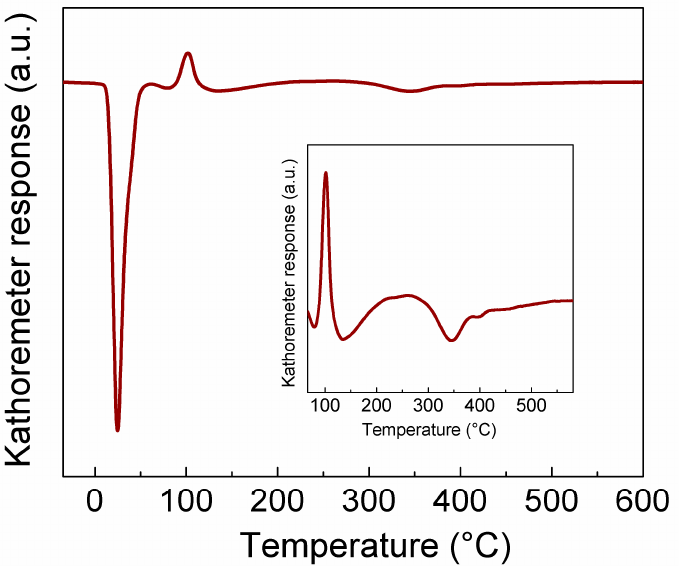
Figure 4. Temperature programmed reduction of 1 wt.% Pd/ γ -Al 2 O 3 after calcination in air at 500 ◦ C. Based on TPR results, the low-temperature reduction conditions were estimated. Three hours of the reduction at 400 ◦ C seems enough to transform Pd 2+ to metallic